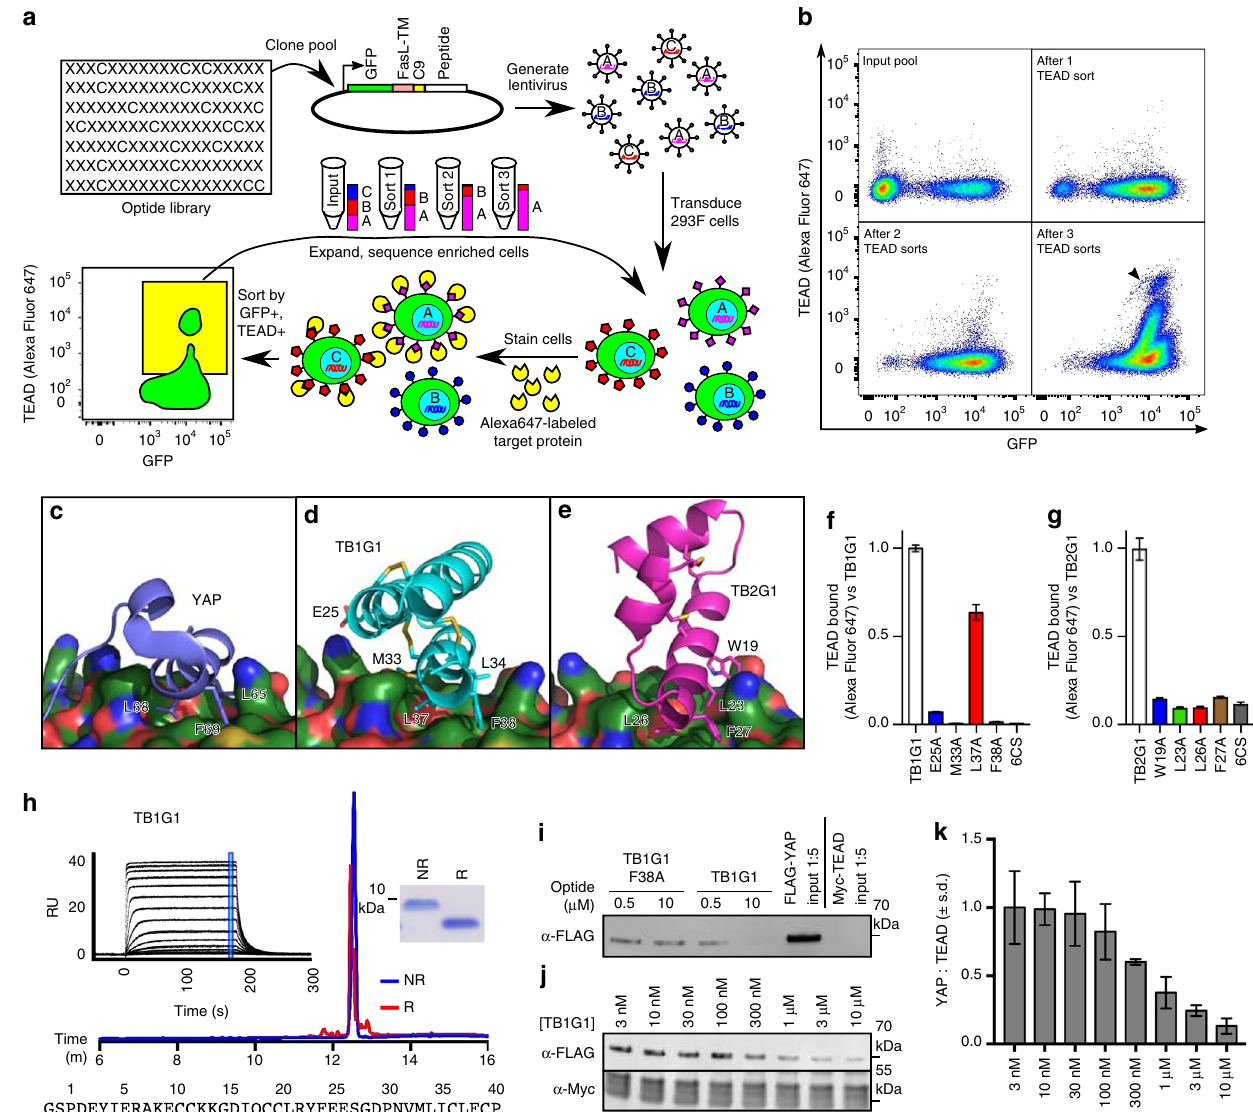
Fig. 4 Mammalian surface display screening identi fi es TEAD-binding optides. a Scheme for the screening strategy. FasL-TM: transmembrane domain of the FasL protein. b Flow pro fi les (GFP vs TEAD-streptavidin-Alexa Fluor 647) of the library of designed optides in SDGF; shown are the pro fi les of the unsorted input library (top left), and the library after one (top right), two (bottom left), or three (bottom right) TEAD sorts. Arrowhead in bottom right corresponds to TB1G1 clone within enriched polyclonal pool. c YAP:TEAD structure from PDB ID 3KYS, focusing on Interface 2. d , e TB1G1 d and TB2G1 e modeled at the same location on TEAD. Both share a conserved “ LXXLF ” motif with YAP. f , g The TEAD-binding abilities of 293F cells transfected with SDGF-TB1G1 f or SDGF-TB2G1 g and interface mutations are shown. 6x Cys to Ser (6CS) to eliminate disul fi de bonds were also tested. Binding quantitated by Alexa Fluor 647 levels in transfected cells using fl ow cytometry. Shown are the normalized median ± 95% con fi dence intervals from one experiment. h Soluble TB1G1 is monodisperse in solution by reversed-phase (RP) HPLC (bottom) and SDS-PAGE (right inset). Reduction with 10 mM DTT was complete and demonstrates a mobility shift in both RP-HPLC and SDS-PAGE. TEAD-binding equilibrium binding constant ( K D ) was 31 ± 2 nM by SPR (left inset, serial 2- fold dilutions of 2 μ M → 0.12 nM in duplicate; RU within blue mark used for curve fi t in Supplementary Fig. 8a; see Methods and Supplementary Table 4 for SPR methodology). NR: Non-reduced. R: Reduced with 10 mM DTT. i TB1G1 and the poorly-binding F38A variant were tested for inhibition of FLAG-YAP co-immunoprecipition with Myc-TEAD in 293T cell lysate. j , k Dilution series of TB1G1 in the FLAG-YAP:Myc-TEAD co-immunoprecipitation assay. j is one representative blot; k is the YAP:TEAD signal ratio, average ± s.d. ( N = 4 lanes per dilution from one experiment), quantitated by band Platform fl exibility facilitates rapid af fi nity maturation . The left inset). Two point mutants at the modeled interface of TB1G1 concentration used to screen for TEAD binders (200 nM) is (L37A and F38A) were also produced, and were indistinguishable similar to that commonly used for yeast display screening 29,45 , from TB1G1 except for increased TEAD-binding K D (Supple- mentary Fig. 4 and Supplementary Table 4), with the degree of and under such conditions, cells displaying TB1G1 stain extre- K D increase correlating with the reduction in surface TEAD mely well (~100x background staining; Fig. 4b, arrowhead). staining (Fig. 4f). Finally, TB1G1 (but not TB1G1-F38A) However, we wished to investigate the sensitivity of the staining demonstrated dose-dependent inhibition of YAP:TEAD binding under conditions of increased stringency, by reducing both the in co-immunoprecipitation experiments (Figs. 4i – k). concentration and the avidity of the interaction. TB1G1 served as